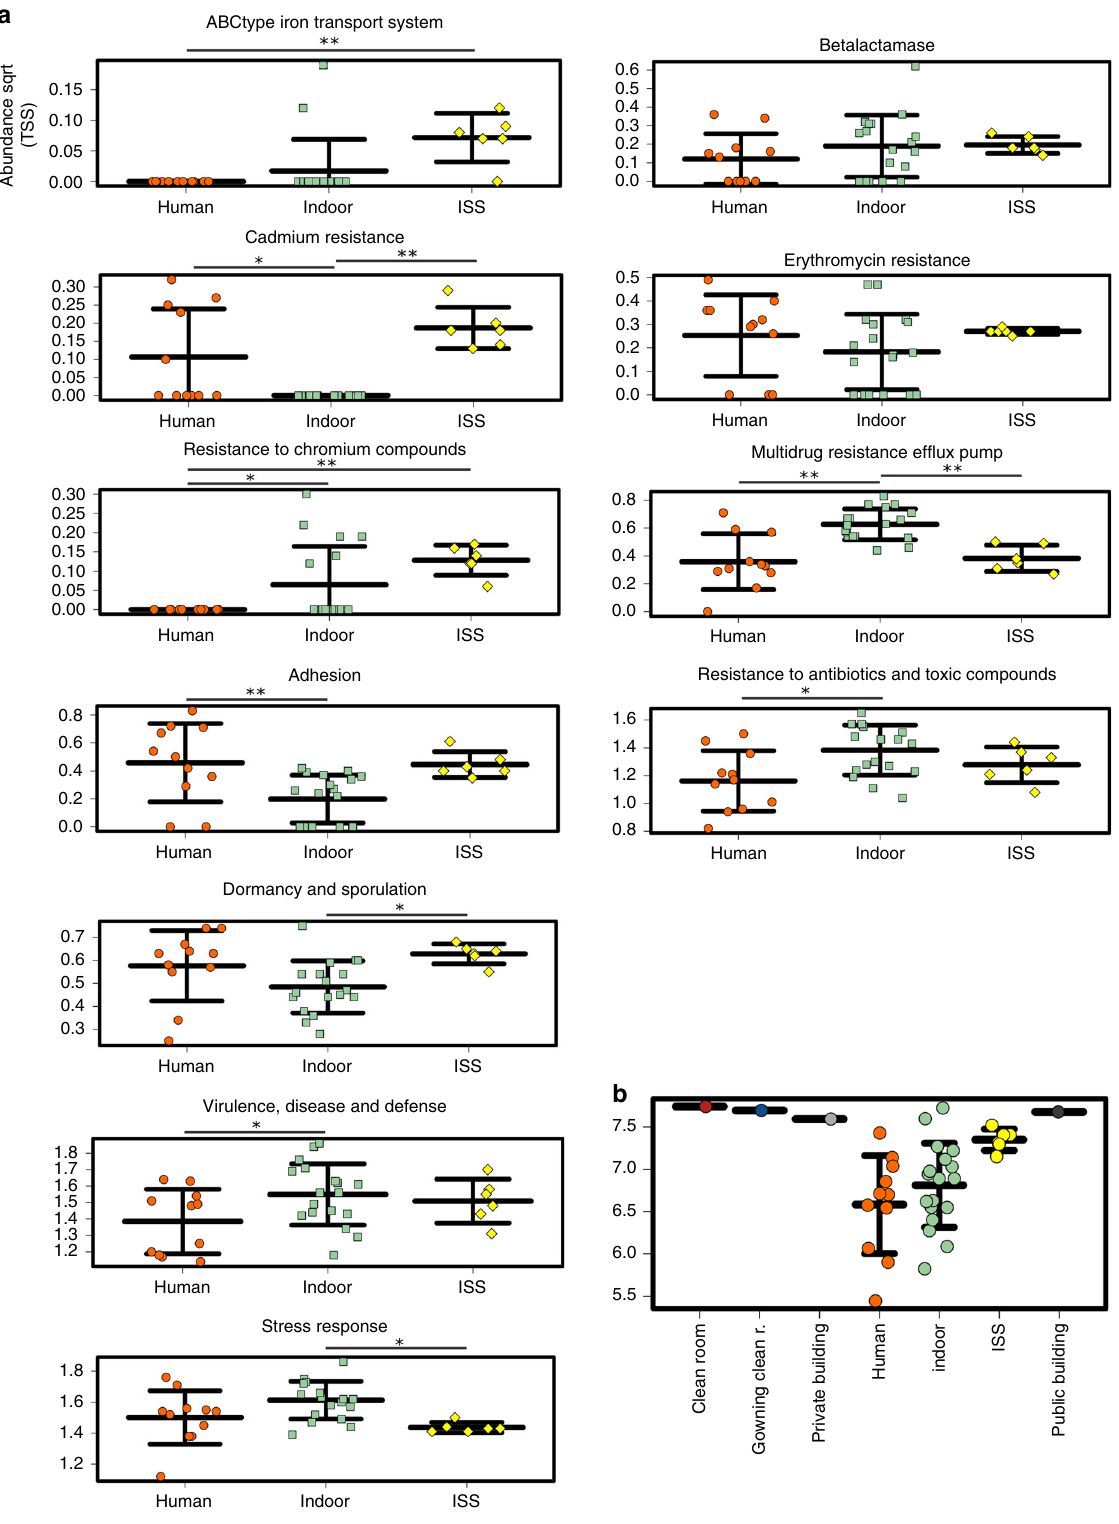
Fig. 9 Functional characteristics. a Relative abundance of gene signatures of respective categories in the metagenomics datasets of the ISS (this study; yellow), terrestrial indoor (green) and human surfaces (orange). Statistical signi fi cance (*: p < 0.05; **: p < 0.01) was inferred using ANOVA, followed by a Tukey – Kramer post hoc test and Benjamini – Hochberg FDR correction. b Shannon diversity index of functions in different data sets. All stripcharts: error bars visualize standard